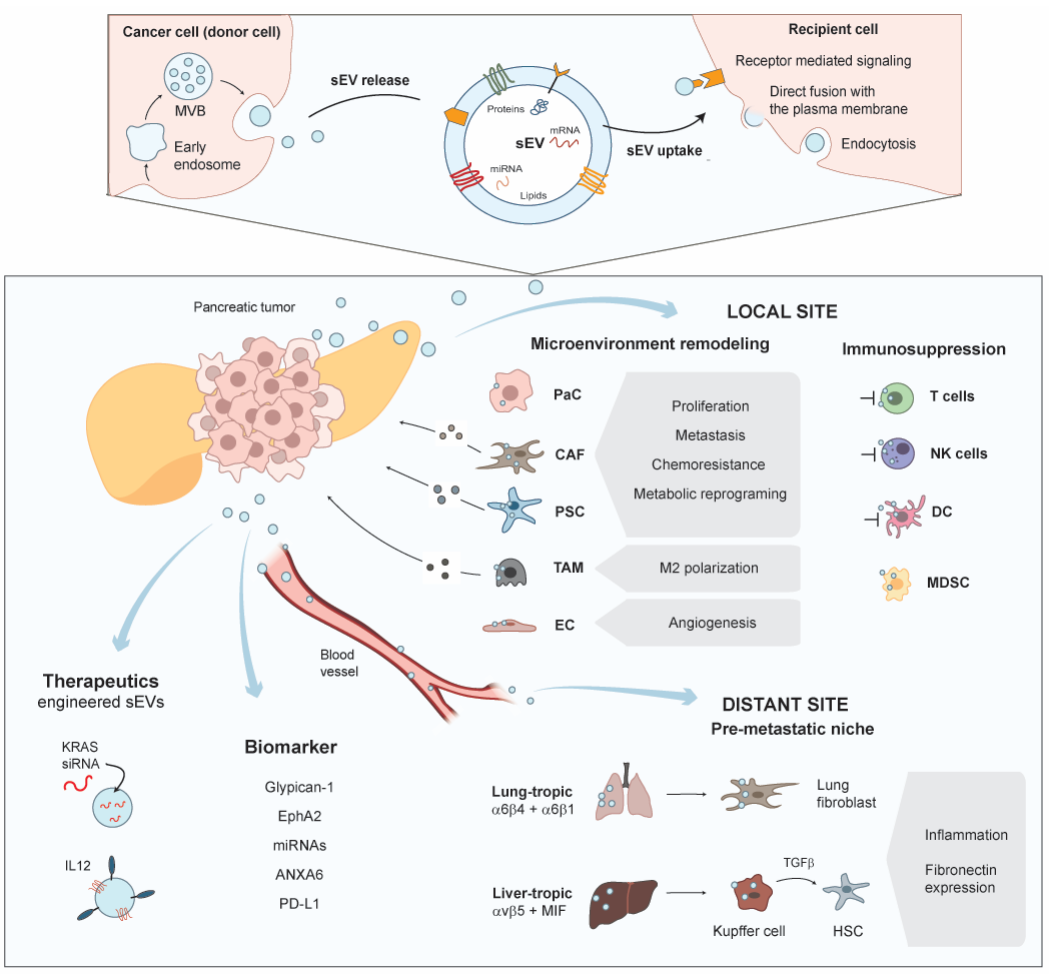
Figure 1. sEVs in short- and long-distance intercellular communication during PDAC initiation, progression, and metas- tasis.